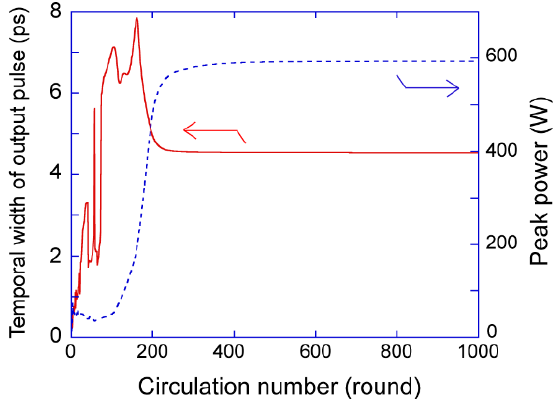
Figure 7. Variation of temporal width and peak power of output pulse for initial passive mode-locking process in dissipative-soliton mode-locking regime ( D T = +0.08 ps 2